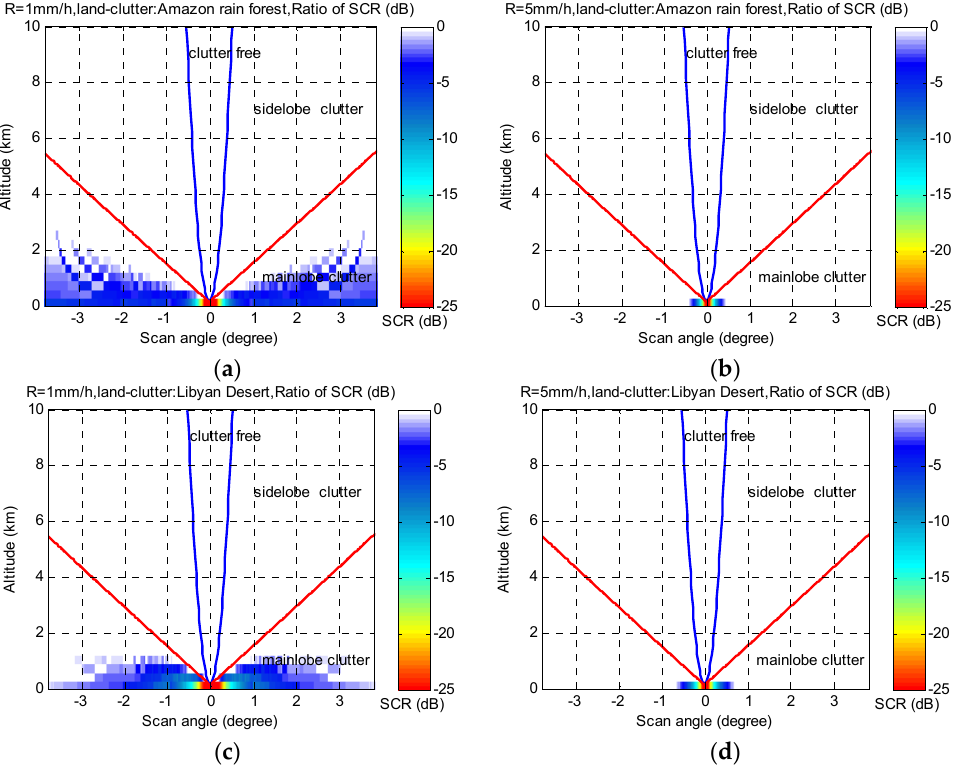
Figure 8. Power ratio of rain echo signal to land surface clutter (SCR), with land terrain of Amazon rainforest and Libyan Desert. ( a ) SCR: 1 mm/h, Amazon rain forest; ( b ) 5 mm/h, Amazon rain forest; ( c ) SCR: 1 mm/h, Libyan desert; and ( d ) 5 mm/h, Libyan desert.